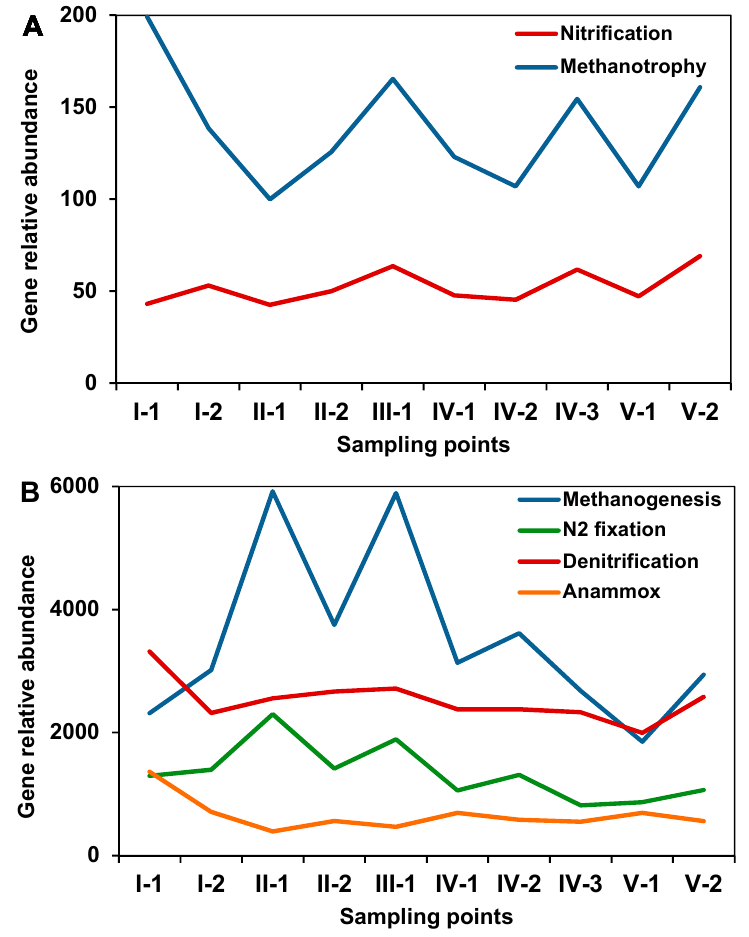
Figure 8. Predicted microbial functional profiles of different zones of the constructed wetland. Processes were divided on two groups: ( A ) aerobic, low abundant processes; ( B ) anaerobic, abundant processes.